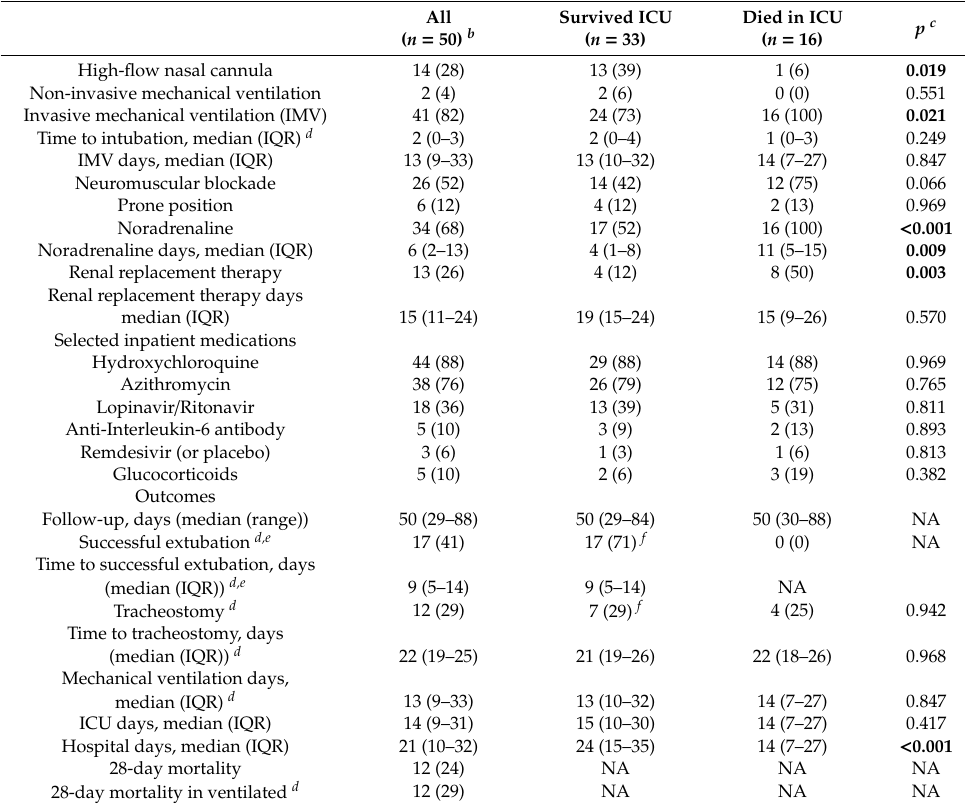
Table 2. Interventions in the ICU and outcomes a